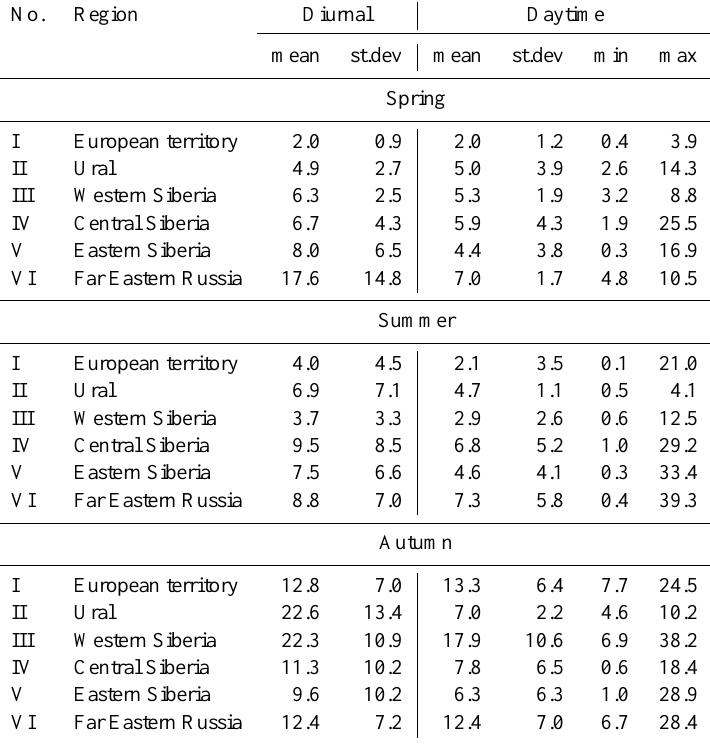
Table 3. Statistics on spatially averaged 1h diurnal and daytime 222 Rn concentrations for the studied Russian regions in different seasons (in Bqm − 3 ) . The numbers of the regions: I – Moscow-Perm (0–1380km from Moscow); II – Perm-Ekaterinburg (1380–1904km from Moscow); III – Ekaterinburg-Novosibirsk (1904–3283km from Moscow); IV – Novosibirsk-Irkutsk (3283–5136km from Moscow); V – Irkutsk-Belogorsk (5136–7818km from Moscow); VI – Belogorsk-Vladivostok (7818–9242km from Moscow).